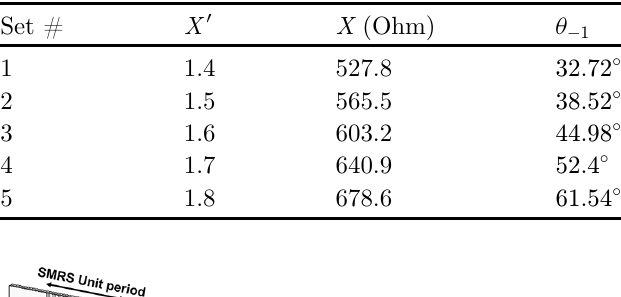
Table 1. Information of surface reactance sets for the different desired radiation angles at 9 GHz.